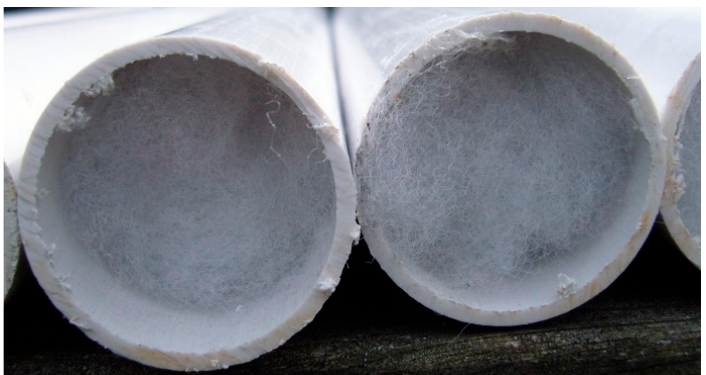
Figure 3. Example of open-ended ZVI cartridges prior to being placed in a reactor train. The entrance to the cartridge is filled with filter wool.